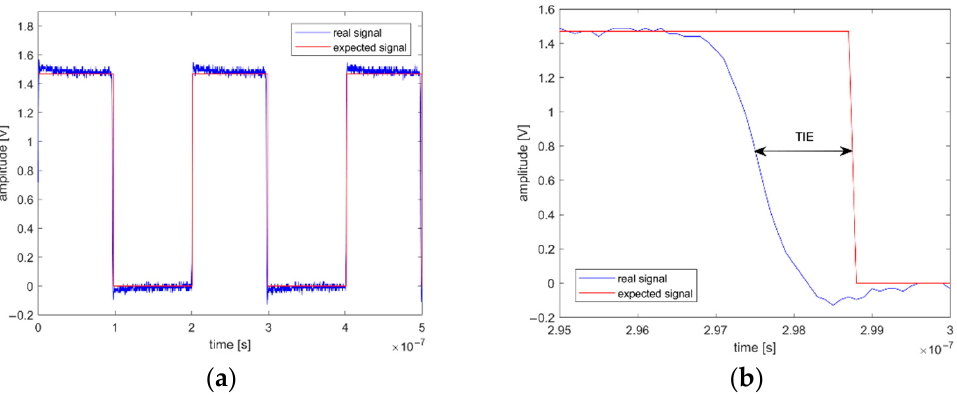
Figure 8. Comparison of raw QCM signal ( a ) real and expected periods; ( b ) real and expected edges.